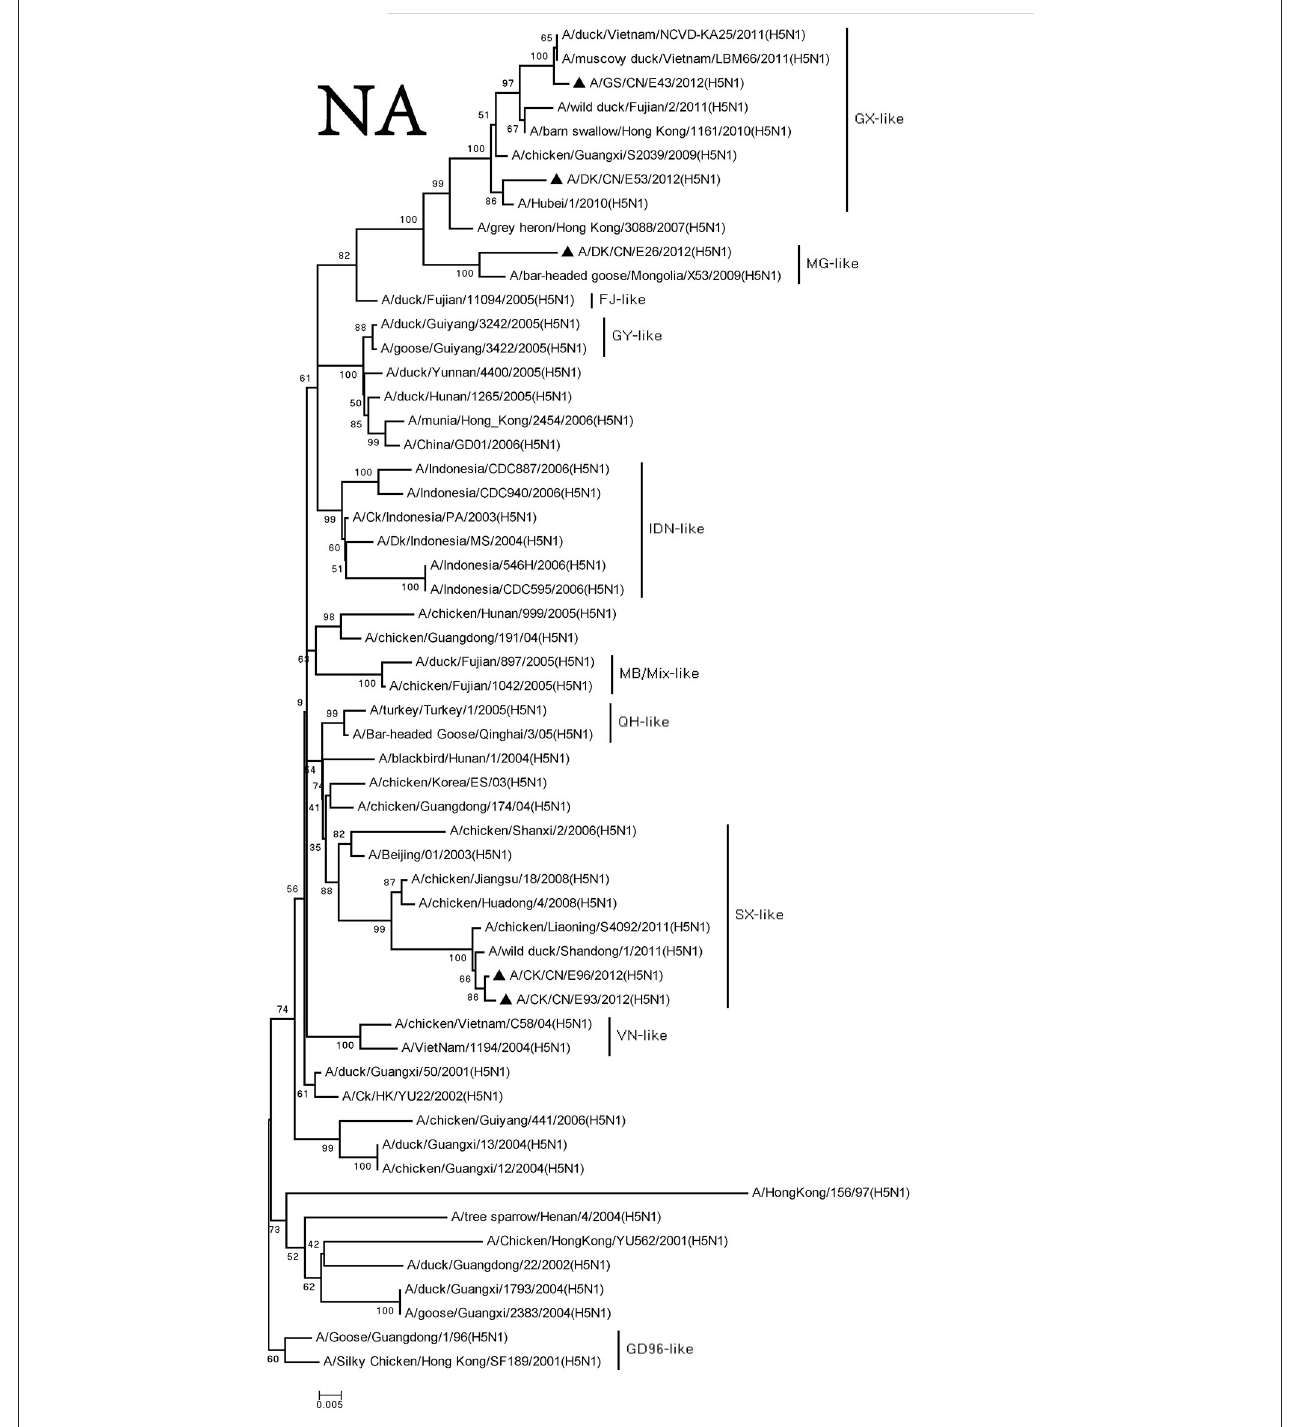
FIGURE 2 | Phylogenetic analysis of NA. NA: nt19–1,380. Except our isolate, other virus sequences were downloaded from GenBank. QH, Qinghai; VN, Vietnam; IDN, Indonesia; GY, Guiyang; MG, Mongolia; GX, Guangxi; HD, Huadong; SX, Shanxi.